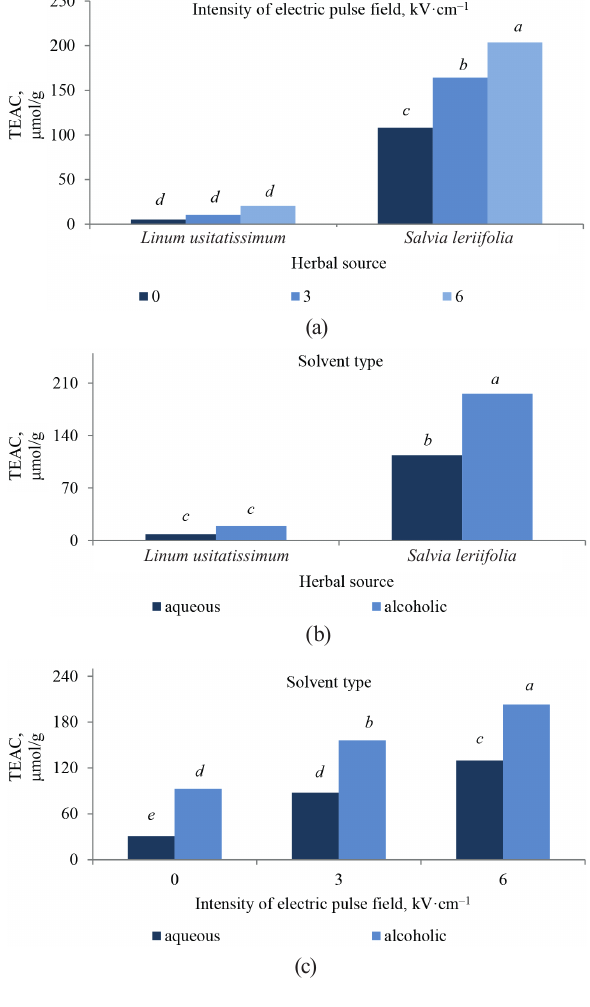
Figure 6 Binary effects of herbal source and pre-treatment (a), herbal source and solvent type (b), and pre-treatment and solvent type (c) on antioxidant activity by TEAC method ( P ˂ 0.05)